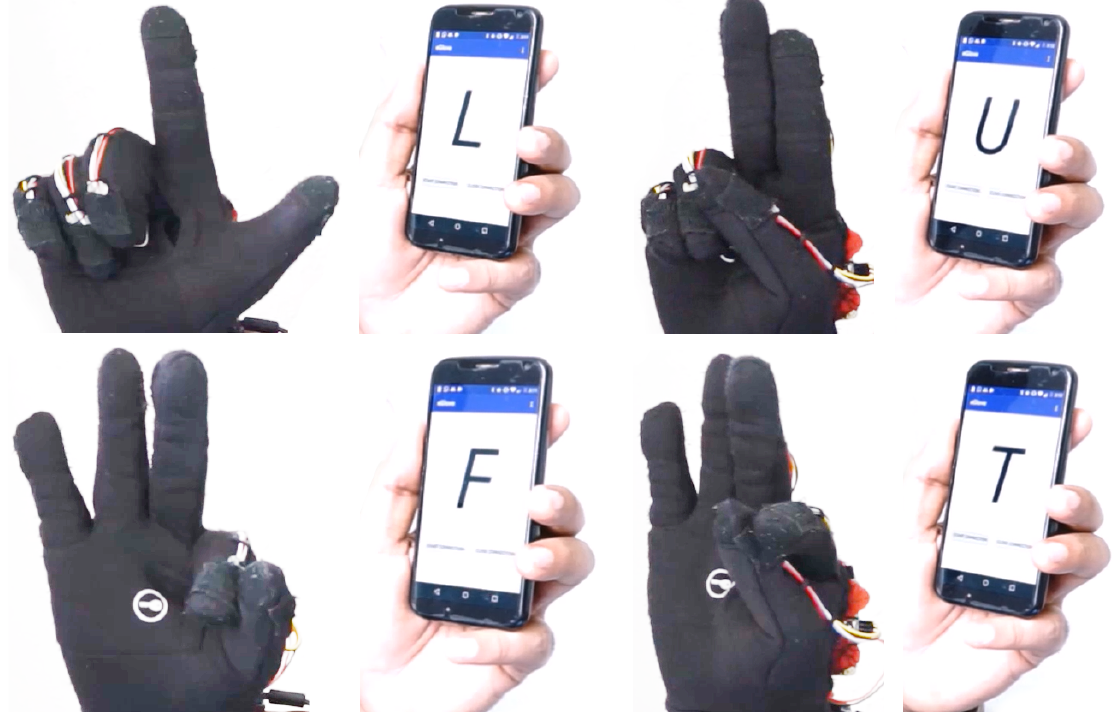
Figure 1. This article’s self-contained data glove is capable of detecting and distinguishing between fine-grained signs in real-time through a set of miniature IMU units, one per finger. Detection is performed on an integrated system placed in the back of the glove, powered from a flat Li-Po battery integrated under the wrist. Shown are four different gestures (out of the 22 we consider in the evaluation) including those that for most gloves are not easily distinguishable from each